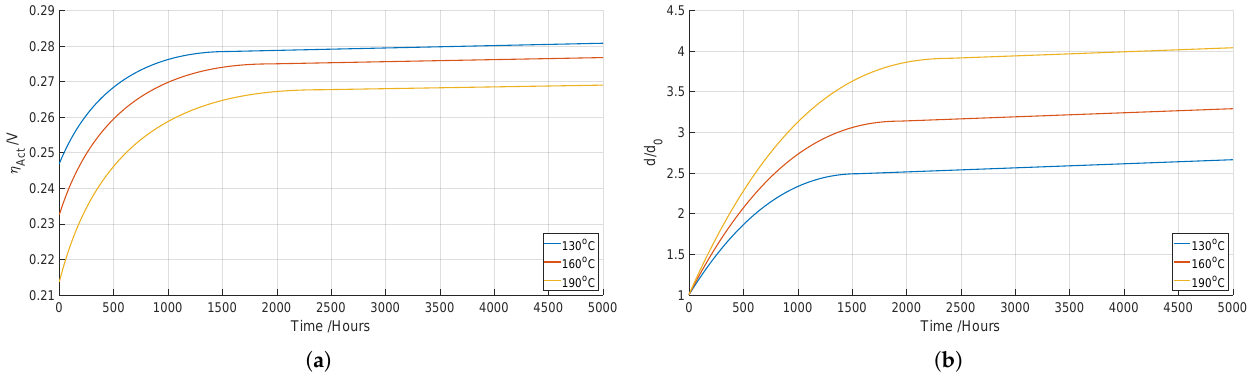
Figure 4. Temperature dependency of activation losses over time. ( a ) Activation overpotential over time as a function of temperature. ( b ) Diameter relative to the initial diameter over time as a function of temperature.